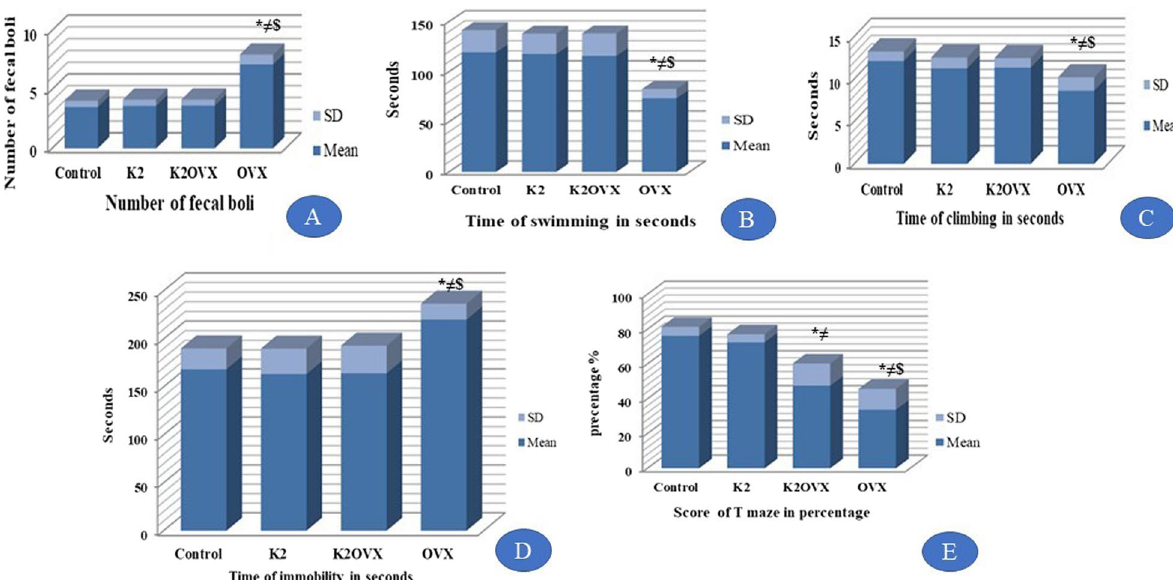
Fig. 4 Histograms A, B, C, D show time spent in different chambers in seconds by Crawley’s sociability test in all the studied groups. * : Significant difference to control group, ≠ : Significant difference to K 2 group, and $: Significant difference to K 2 OVX group